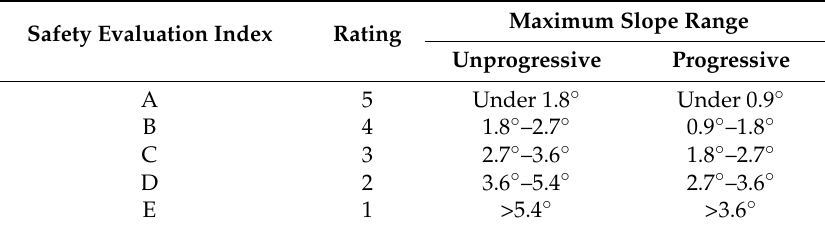
Table 9. Safety Evaluation Index (SEI) for the FBG angle